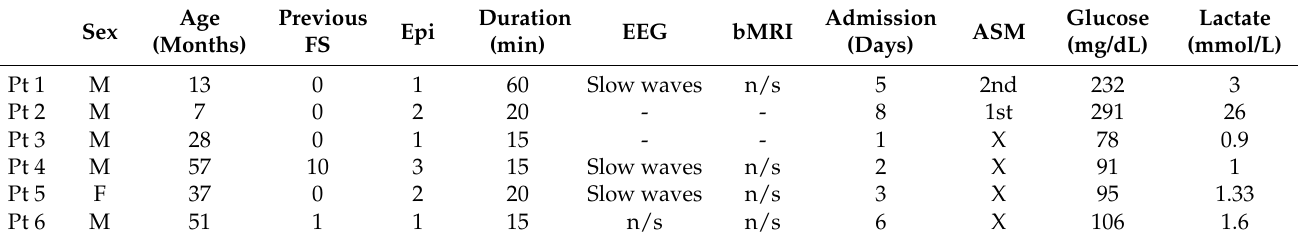
Table 3. Clinical characteristics of prolonged febrile seizures with